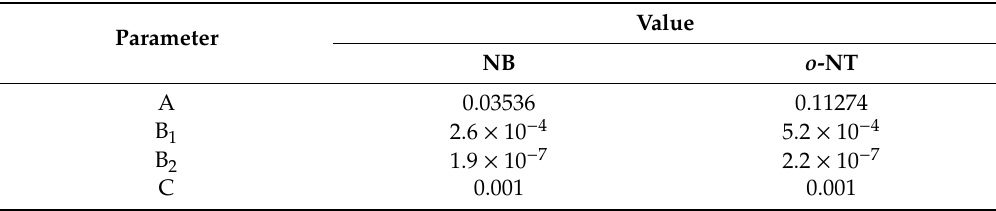
Table2. ConstantsinEquation(27)forestimatingthemaximumdetectableconcentrationofnitrobenzene Table 2. Constants in Equation (27) for estimating the maximum detectable concentration of and o -nitrotoluene nitrobenzene and o -nitrotoluene vapors.